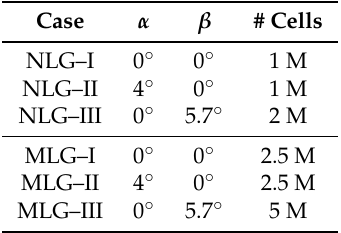
Table 1. Summary of different calculations presented with the number of FV